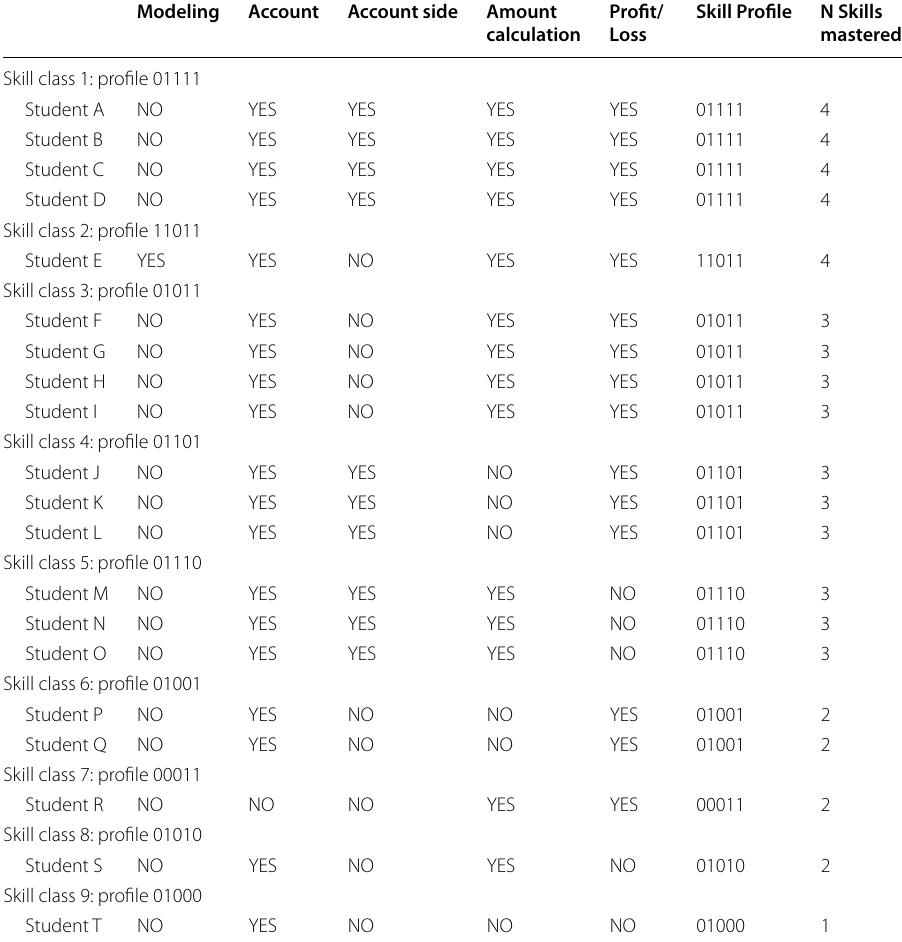
Table 10 Skill class distribution for NC-RUM30 for a given school class Modeling Account Account side Amount